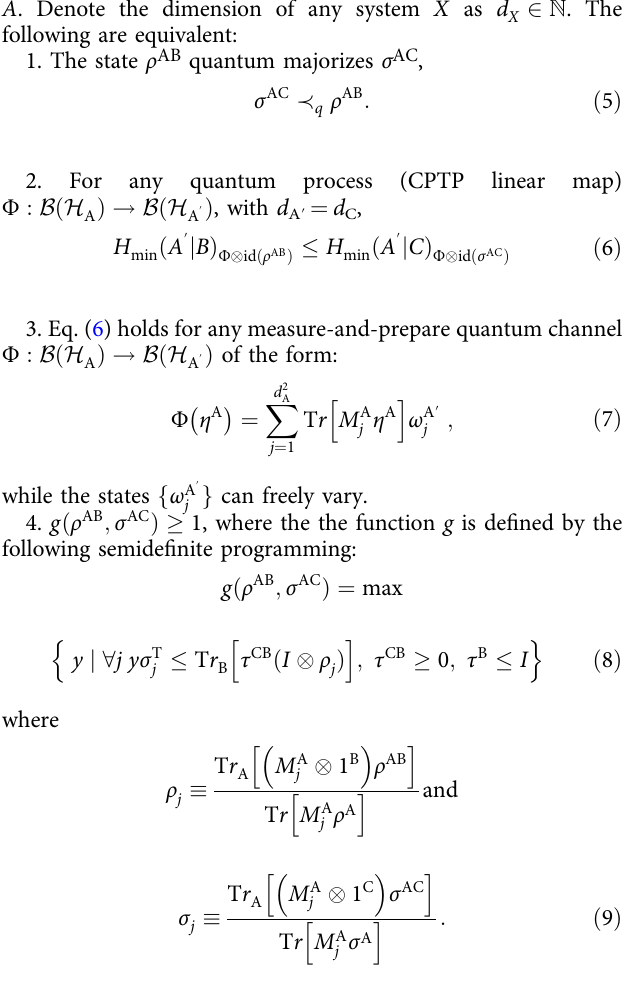
Φ (cid:5) id Þ q ð